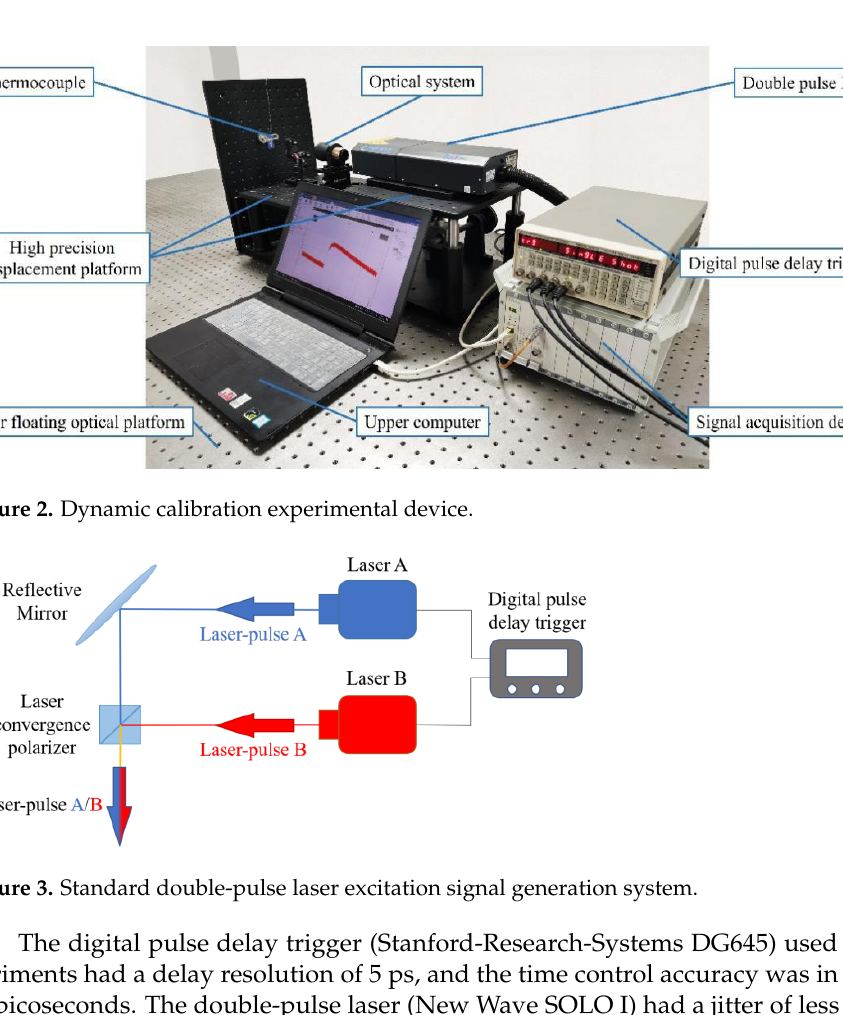
Figure 3. Standard double-pulse laser excitation signal generation system.